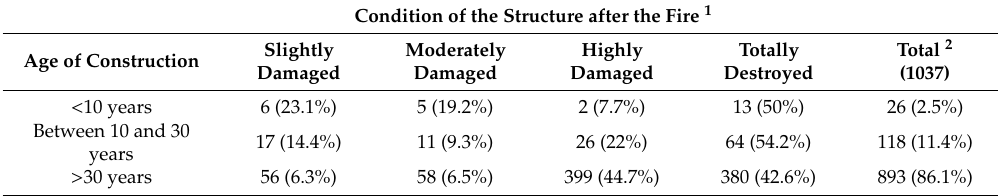
Table 7. Degree of damage according to the approximate age of the